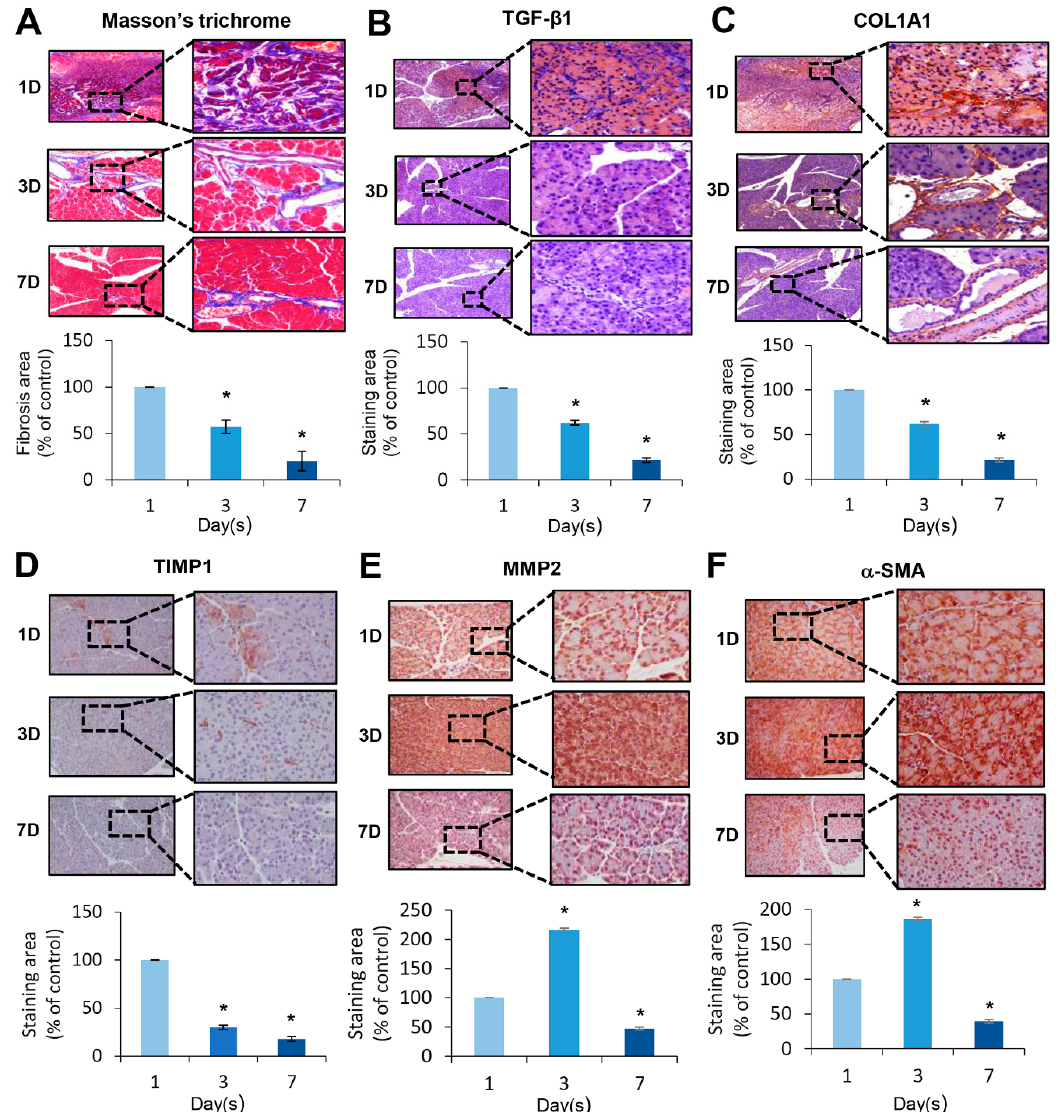
Figure 3. Histological changes induced by the injection of penicillin G. ( A ) Masson-trichrome stains of mouse pancreas after injection of penicillin G. The degree of fibrosis was highest at the first day after injection and decreased gradually thereafter until seven days after injection. ( B – F ) TGF- β 1, COL1A1, TIMP1, MMP2, and α -SMA immunohistochemistry of mouse pancreas after injecting penicillin G. In TGF- β 1, COL1A1, and TIMP1 immunohistochemistry, the expression of the markers was the highest on the first day after injection, and gradually decreased thereafter until seven days after injection. In MMP2 and α -SMA immunohistochemistry, the expression of the markers was highest at three days after injection and decreased thereafter until seven days after injection. Values are presented as mean ± standard deviation of three independent experiments. * p <